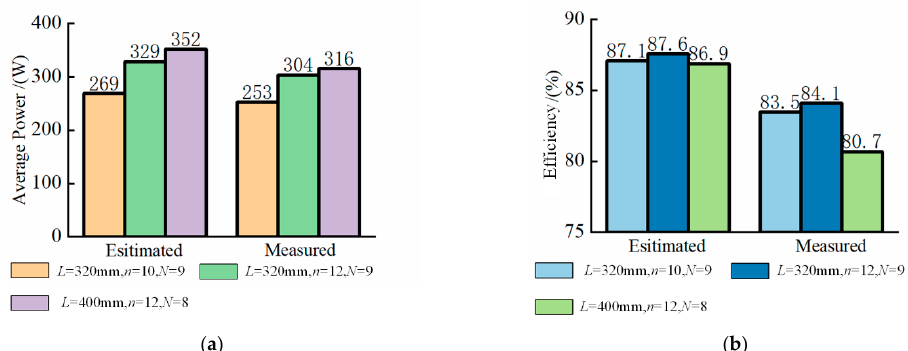
Figure 12. Comparison between estimated and measured: ( a ) power; ( b ) efficiency.